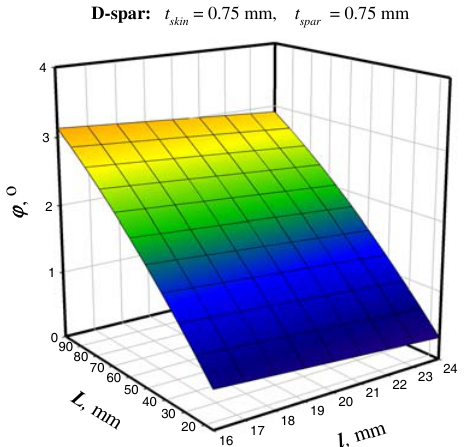
Fig 19. The dependencies of torsion angle on MFC chord-wise length and spar circular fitting